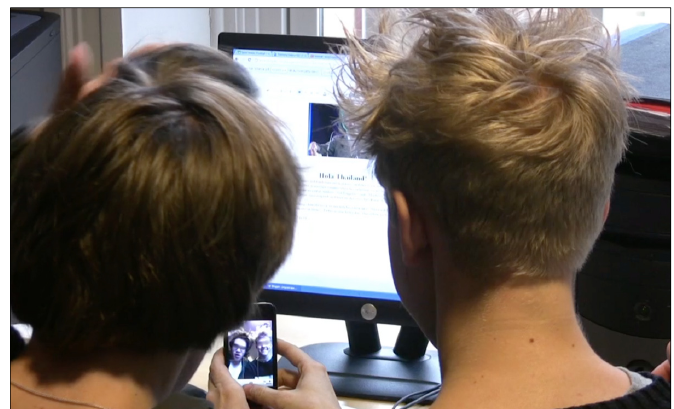
Figure 2. Poppe and Indizz looking at their